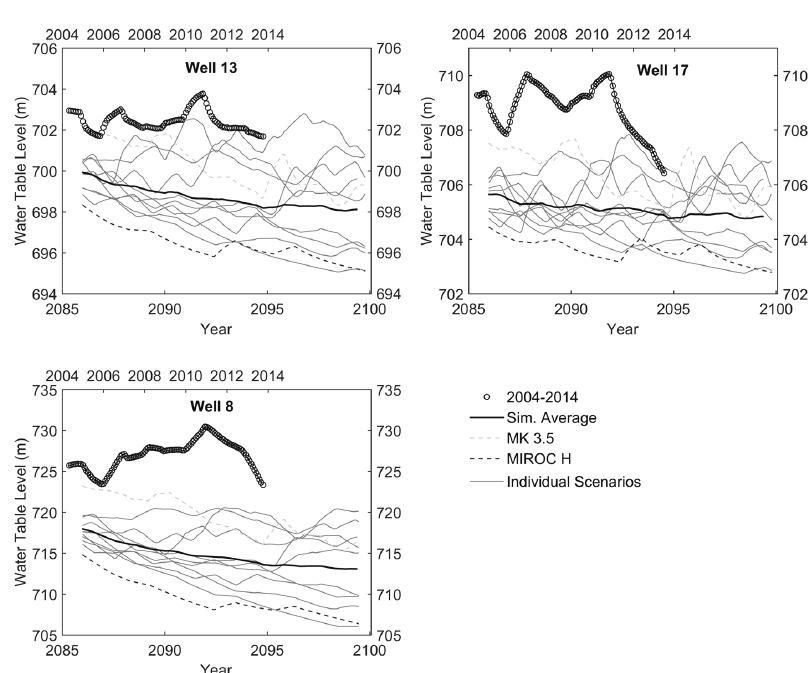
Figure 11 - Moving average of observed (circles) and simulated (lines) hydrographs in three wells considering the proposed land use change